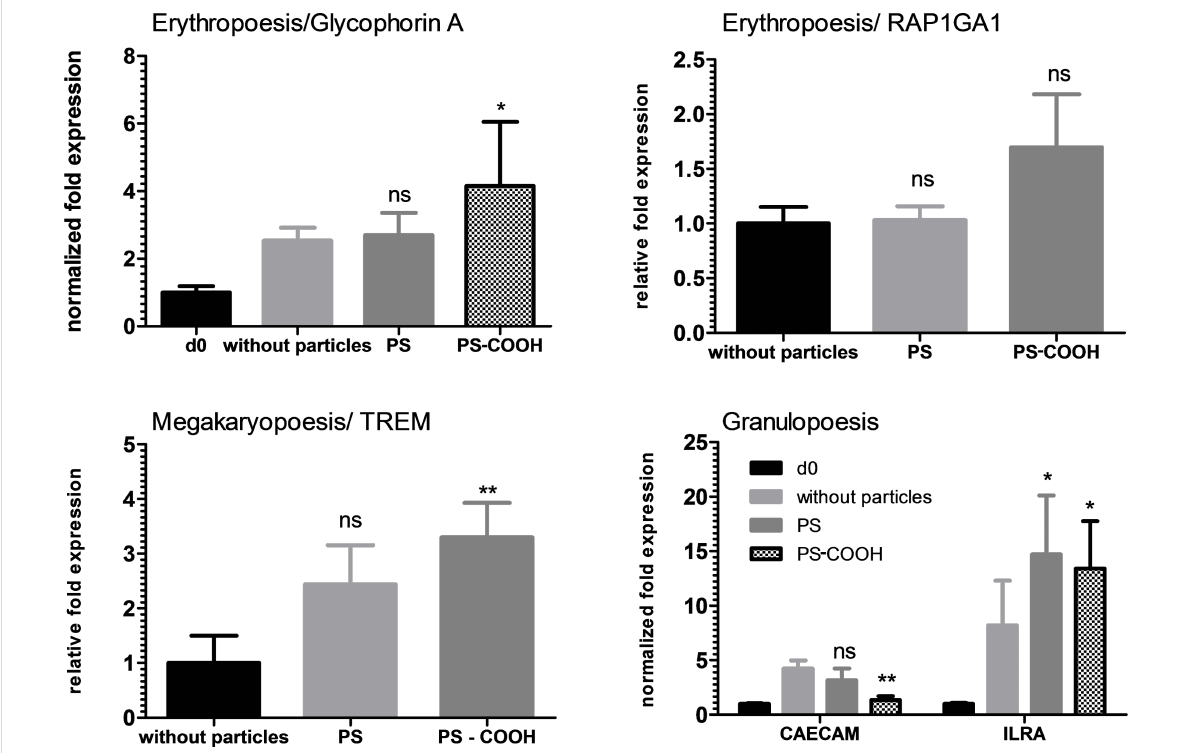
Figure 8: qPCR results of polystyrene particles in hHSCs. Carboxy-functionalized polystyrene particles PS–COOH showed a slight increase in glycophorin A, TREM and ILRA transcription, while a decrease for CAECAM was observed. For pure polystyrene, only ILRA was increased.